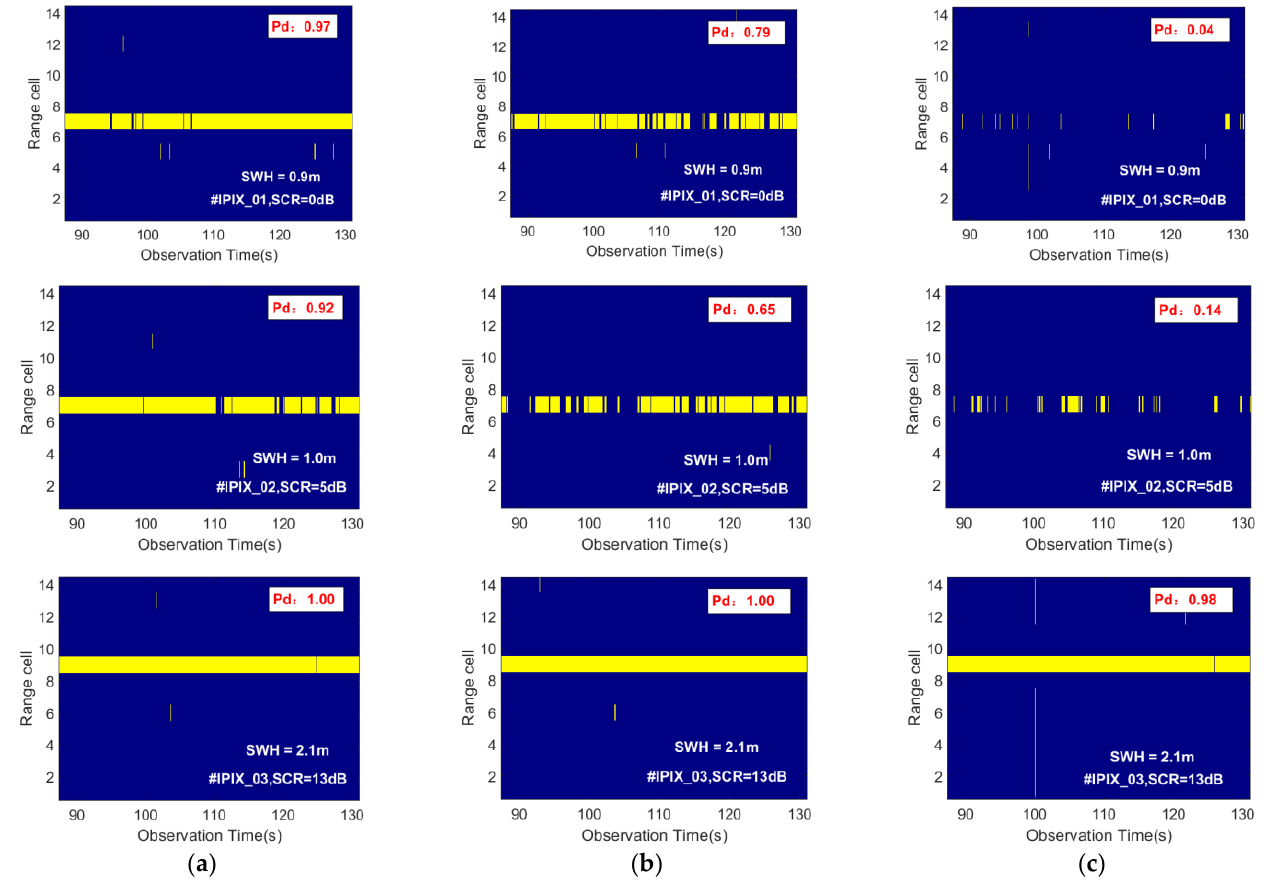
Figure 10. The detection results of different detection methods are visualized under different SCR sea state conditions. The detection result is obtained from the test samples. The radar observation target is the floating ball, the radar observation time is 0.512 s, and the false alarm probability is 10 − 3 . The detection results of data #IPIX_01, #IPIX_02, and #IPIX_03 are shown from top to bottom by the row. The yellow marker is the detected target location. ( a ) Proposed detector; ( b ) Feature-based detector using three TF features [19]; ( c ) Tri-feature-based detector